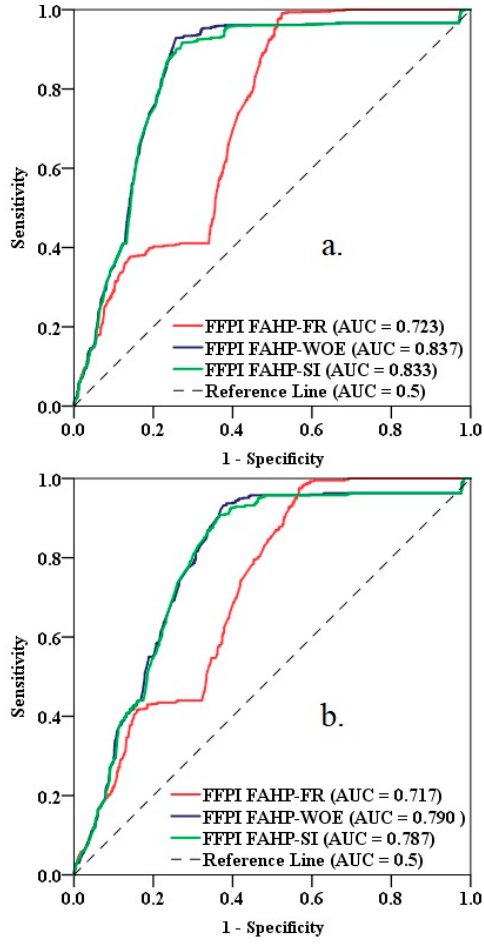
Figure 7. Receiver operating characteristic (ROC) Curves. ( a ) Success rate; ( b ) Prediction rate.